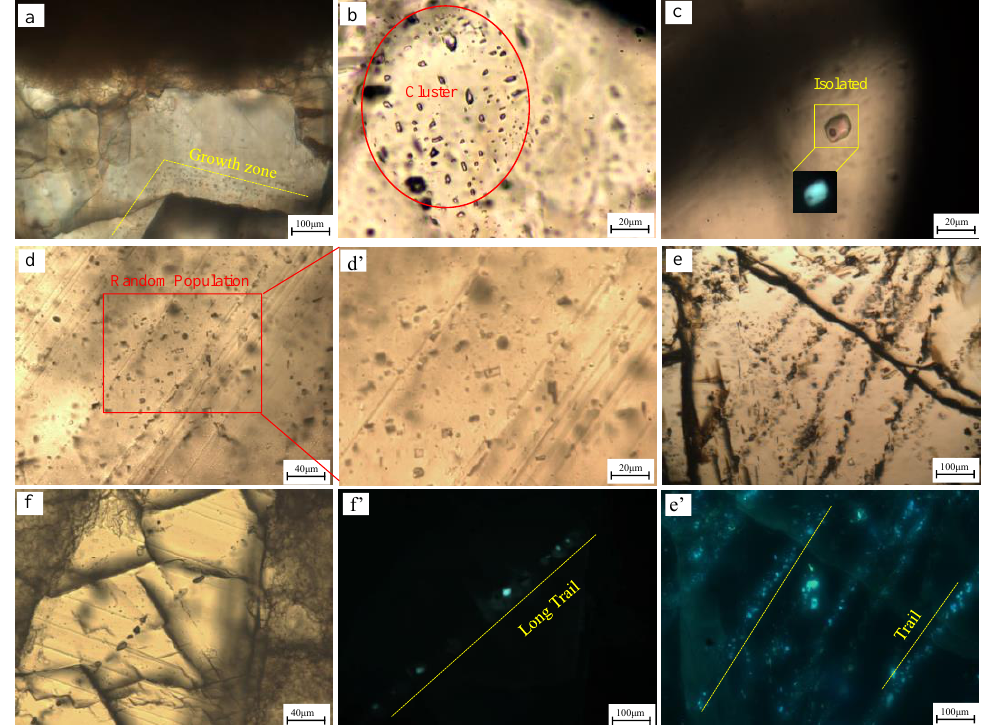
Figure 5. Types of fluid inclusions in the Lower–Middle Ordovician of the Shunbei area. The photomicrographs a, b, c, d, e, e’, and f were taken under transmitted light, and the photomicrographs a’, and c’ were taken under ultraviolet excitation light. ( a ) SHB52A well, O 1–2 y , 8121.61 m, dolomitic micritic limestone, fluid inclusions distributed along the growth zone show primary fluid inclusions; ( b ) SHB51X well, O 2 yj , 7564.66 m, bioclastic limestone, cluster-distributed fluid inclusions